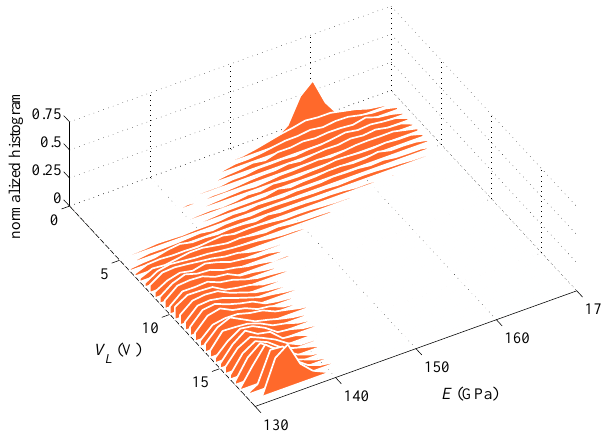
Figure 9. Specimen #2, lateral actuation case, ξ O = ξ E = 0.75: evolution of the PDFs of ( a ) O and ( b ) E corresponding to the evolution of estimates represented by orange curves in Figure 7a.